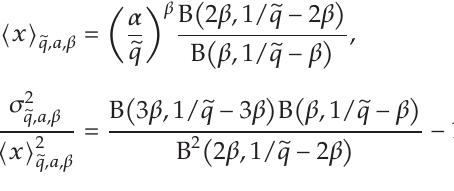
is the Pochhammer symbol.